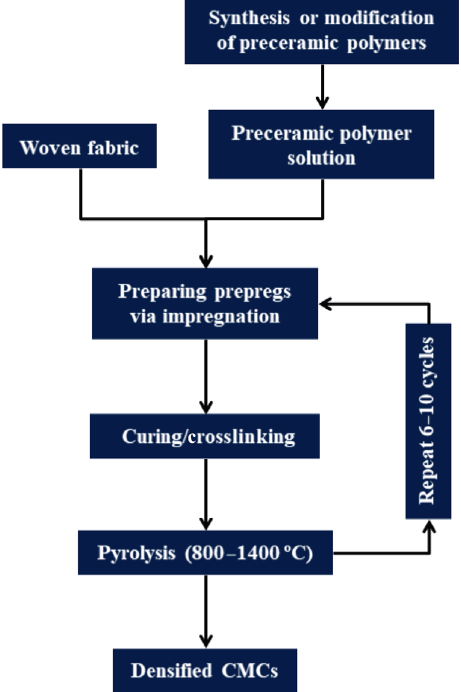
Fig. 7 Flow chart of PIP processing protocol to fabricate polymer-derived CMCs